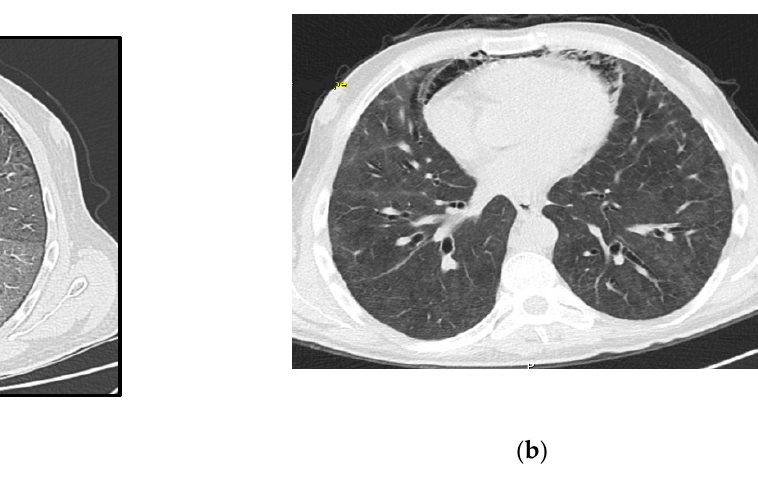
Figure 1. Case 1 thoracic CT-scan at diagnosis ( a ) and follow-up ( b ). 2.2. Case 2